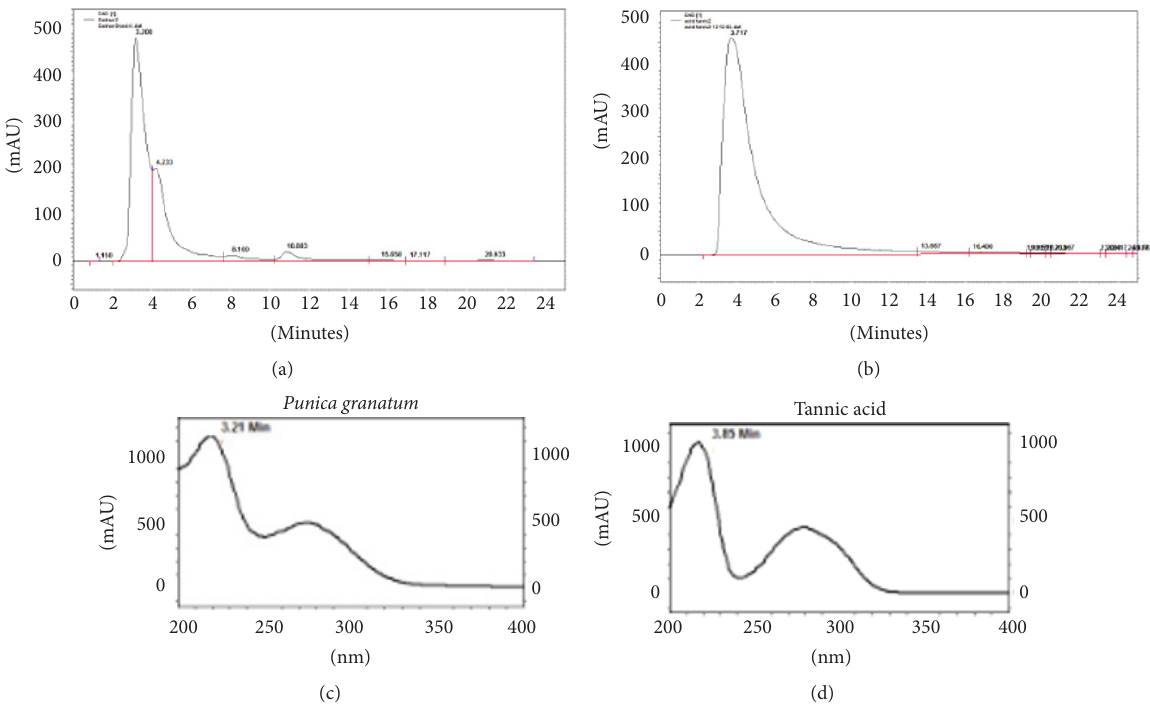
Figure 1: HPLC profile of Punica granatum total extract and tannic acid analyzed. (a) HPLC chromatogram of Punica granatum extract, (b) HPLC chromatogram of tannic acid (retention time: 3.8), (c) UV spectrum of peak Punica granatum extract with a retention time of 3.2, and (d) UV spectrum of tannic acid.